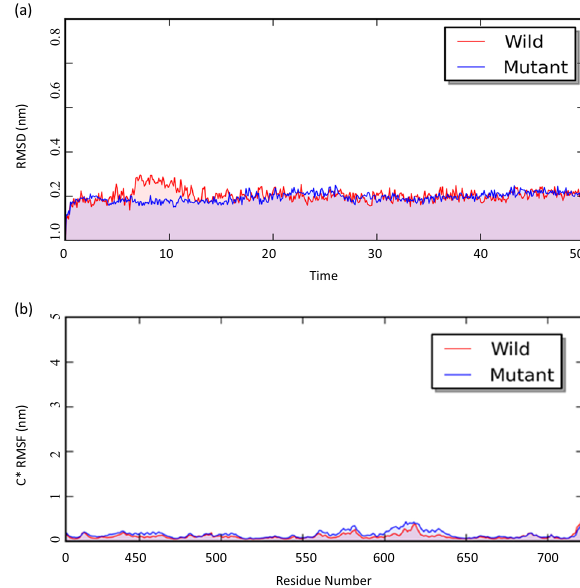
Figure 3: Simulation results: ( a ) RMSD at 50 ns time interval; and ( b ) RMSF results for the 400 – 722 aa residue of the GNE transcript